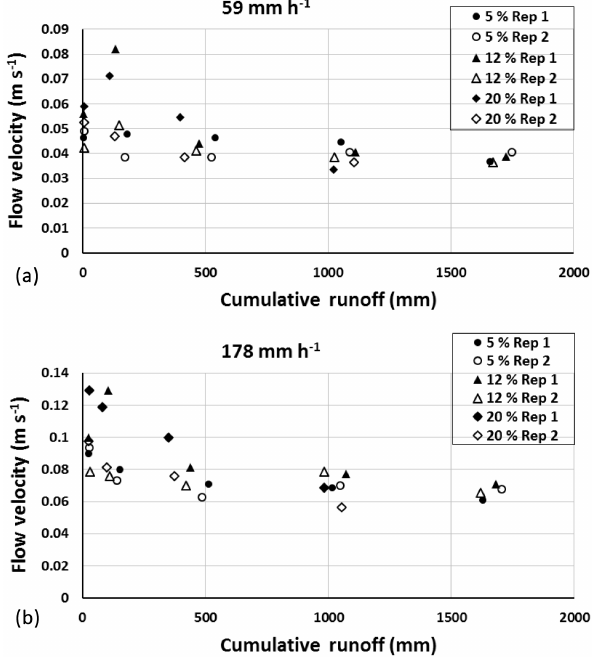
Figure 6. Flow velocities down the full plot as a function of cumu- lative runoff depth for (a) I = 59mmh − 1 and (b) I = 178mmh − 1